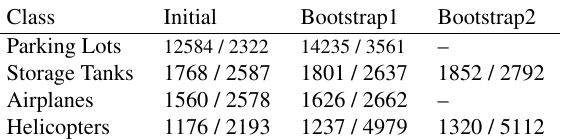
Table 1: Summary of training data for McChord AFB. Each en- try provides the number of positive / number of negative training samples, in total, at each stage.